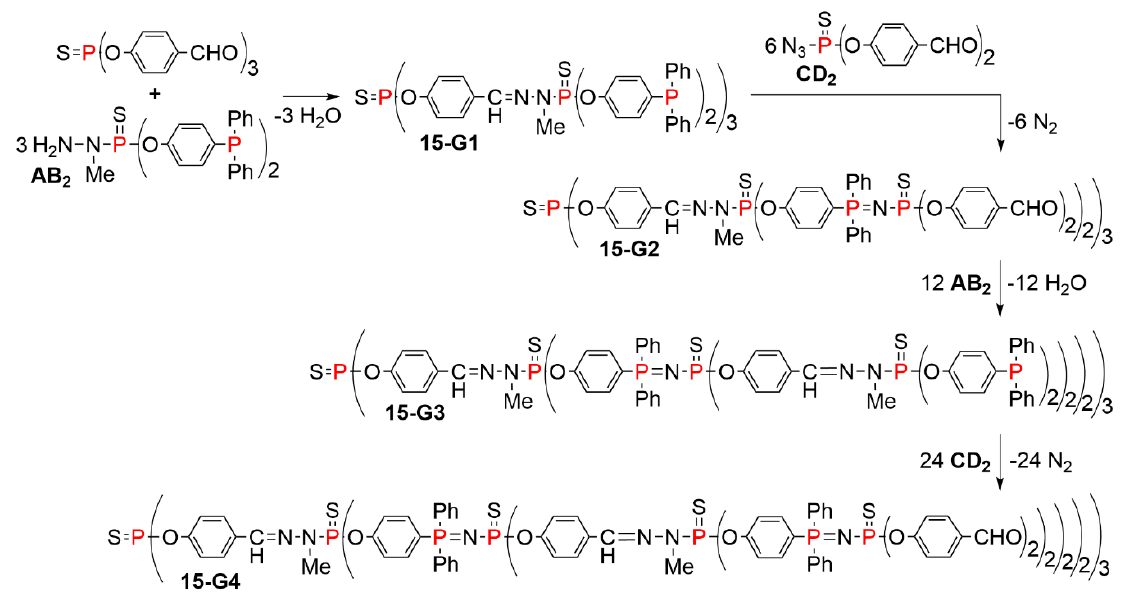
Figure 9. Another dendrimer synthesized as shown in Scheme 14, starting from triphenyl phosphine as the core.